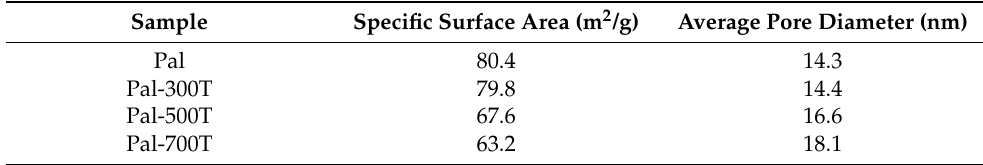
Table 2. Specific surface area (S BET ) and average pore diameter (D p ) of palygorskite before and after